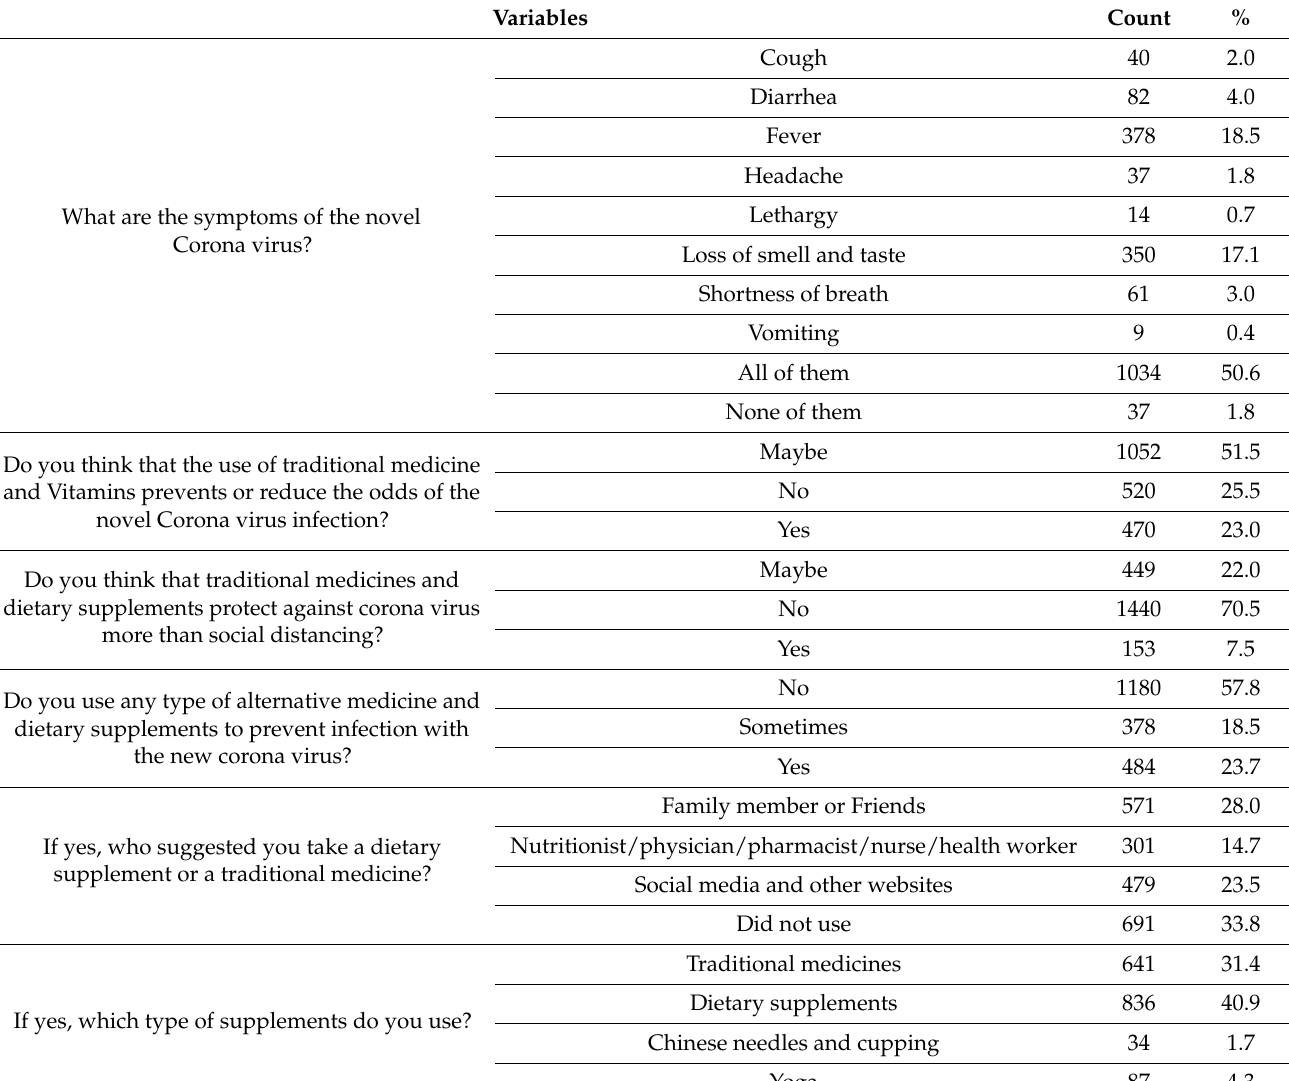
Table 2. Awareness and knowledge of alternative